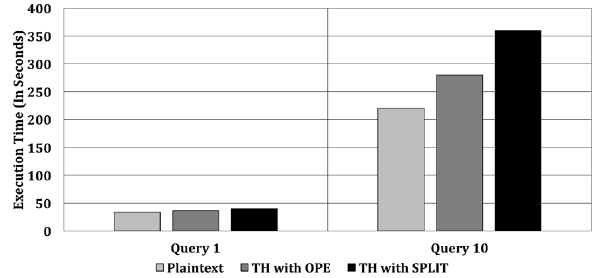
Fig. 10 Query execution time (10GB TPC-H